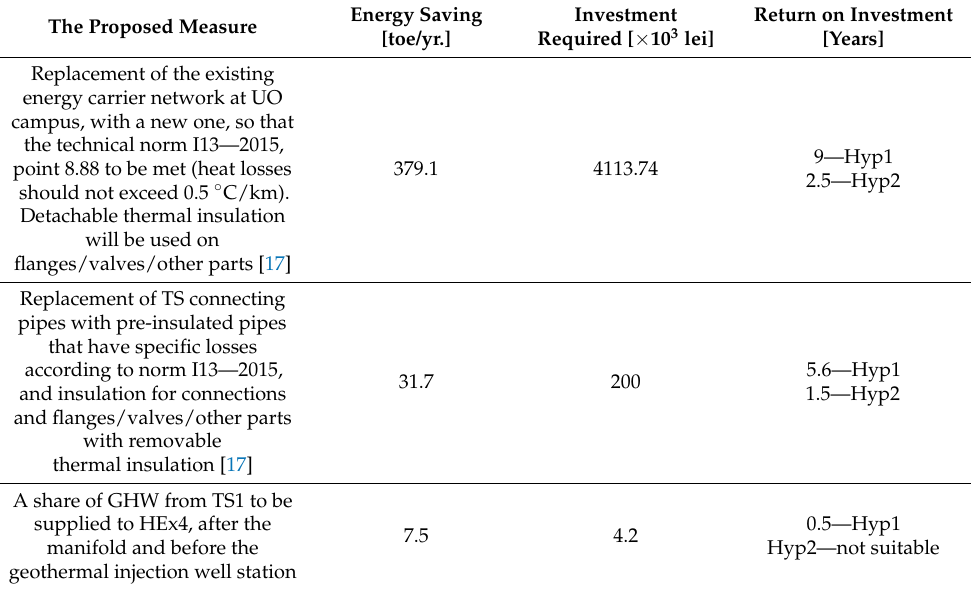
Table 15. Recommended measures to improve energy efficiency on the UO campus